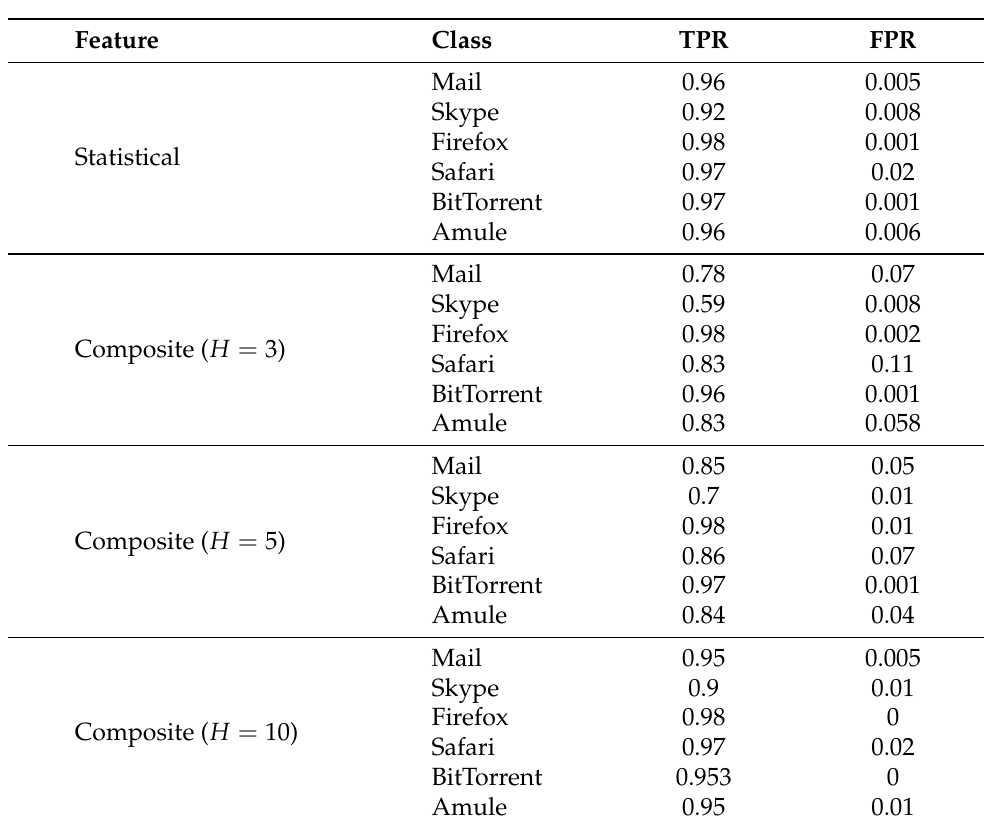
Table 9. C4.5: Performance over UniBS data